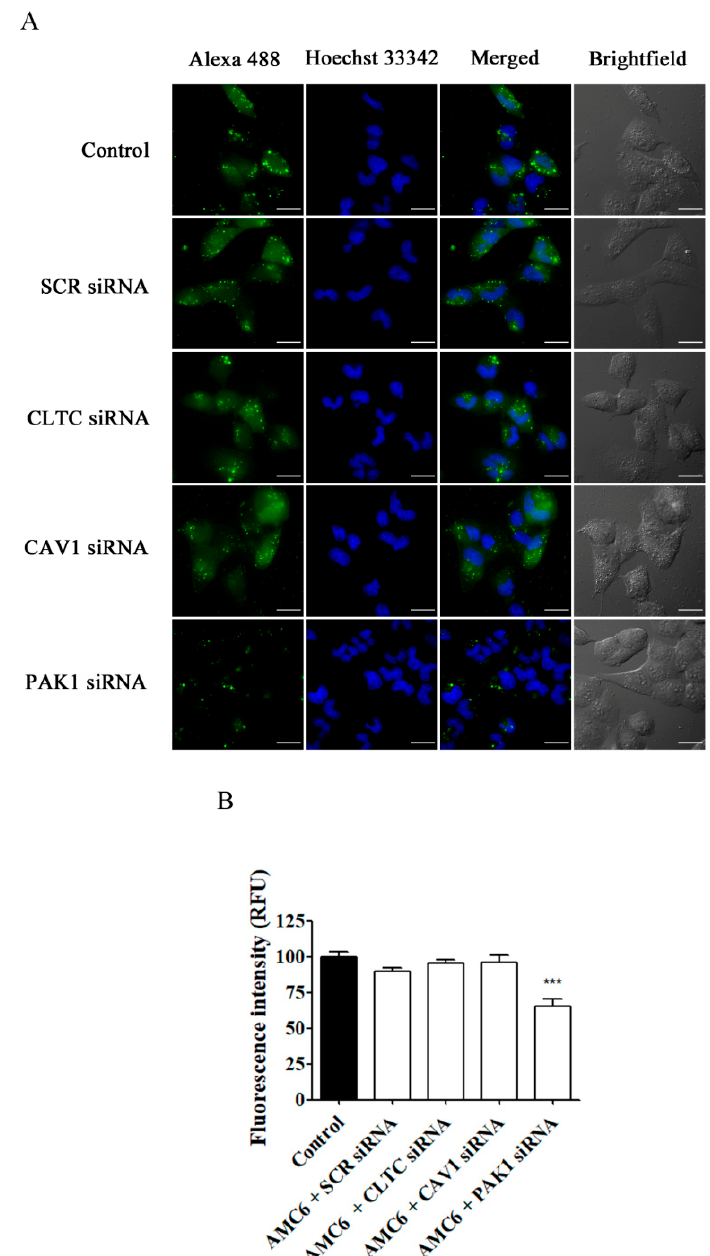
Figure 8. Effect of knocking down key proteins in CME, CVME and macropinocytosis on the uptake of AMC6/Alexa Fluor 488-labelled siRNA. T98G glioblastoma cells were pre-treated for 48 h with vehicle (control) and AMC6/siRNA complexes (1 µM/50 nM) consisting in SCR siRNA, or specific siRNAs targeting CLTC, CAV1, and PAK1. After this, cells were treated for 6 h with AMC6/alexa488 siRNA (green) complexes (1 µM/100 nM) and with Hoechst 33,342 (25µ/mL) (blue) for 10 min before image recording. ( A ) The images panel ( A ) shows Alexa Fluor 488-siRNA, Hoescht 33,342 and the overlay of both images). In addition, DIC images are also shown. Scale bars: 25 µm; ( B ) Quantification of fluorescence (expressed in RFU) for all the experimental conditions. Data are expressed as the mean ± SEM ( n = 100). *** p < 0.001, compared to control cells.